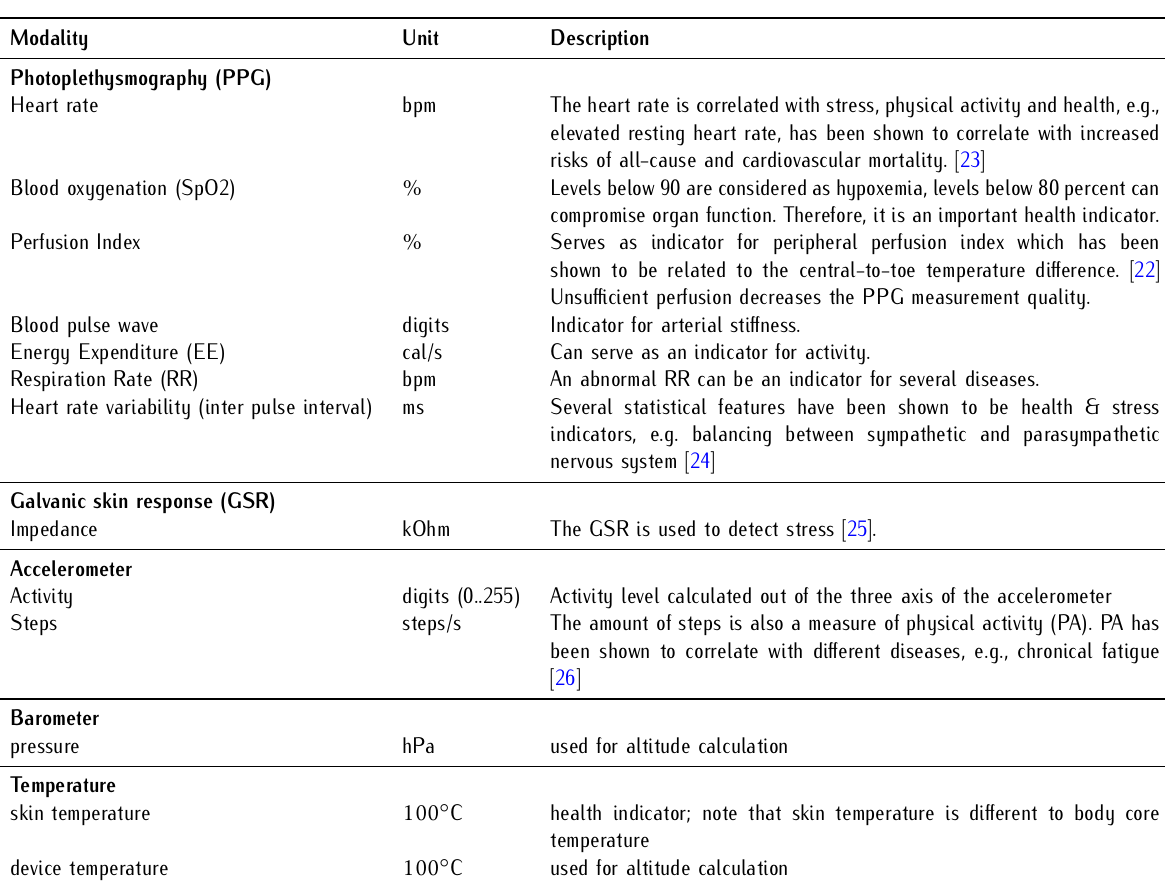
Table 2. Recorded armband data, grouped by sensor